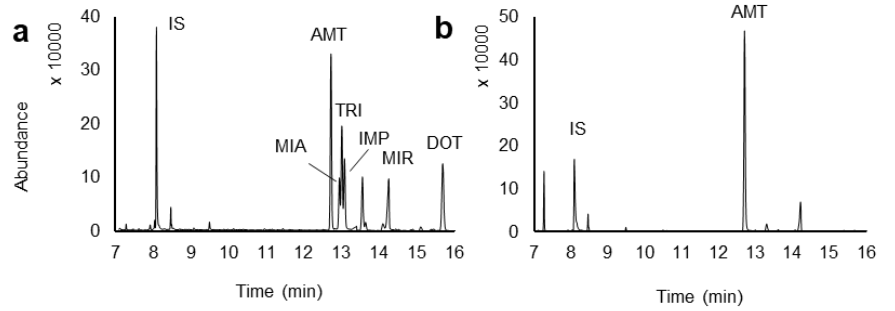
Figure 6. Chromatograms obtained from urine samples spiked at the 100.0 μg L − 1 for six TCAs ( a ) and a positive anony- mous donor without spiking ( b ) analyzed through BAμE(C18)-μLD/LVI-GC-MS(SIM) methodology, under optimized experimental conditions.